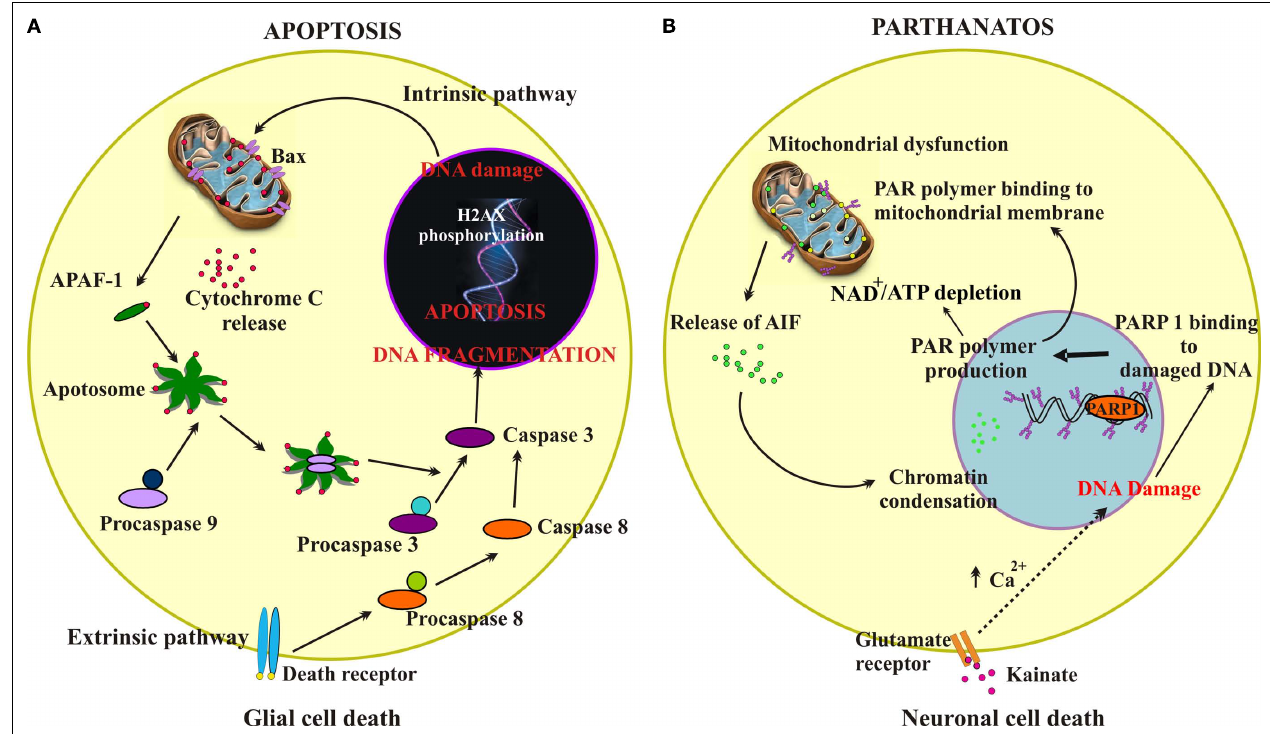
FIGURE 4 | Schematic representation of apoptosis or parthanatos cell-death pathways. (A) Schematic representation demonstrating intrinsic and extrinsic pathways of apoptosis.The intrinsic pathway is initiated from within the cell usually in response to cellular signals resulting from DNA damage, hypoxia, or other types of severe cell stress.These signals stimulate proapoptotic proteins (e.g., Bax) in the mitochondrial membrane leading to mitochondrial membrane permeabilization, that allows translocation of cytochrome c from the mitochondrial intermembrane space to the cytosol. Cytochrome c binds the adaptor apoptotic protease activating factor-1 (APAF-1), forming a large multiprotein structure known as the